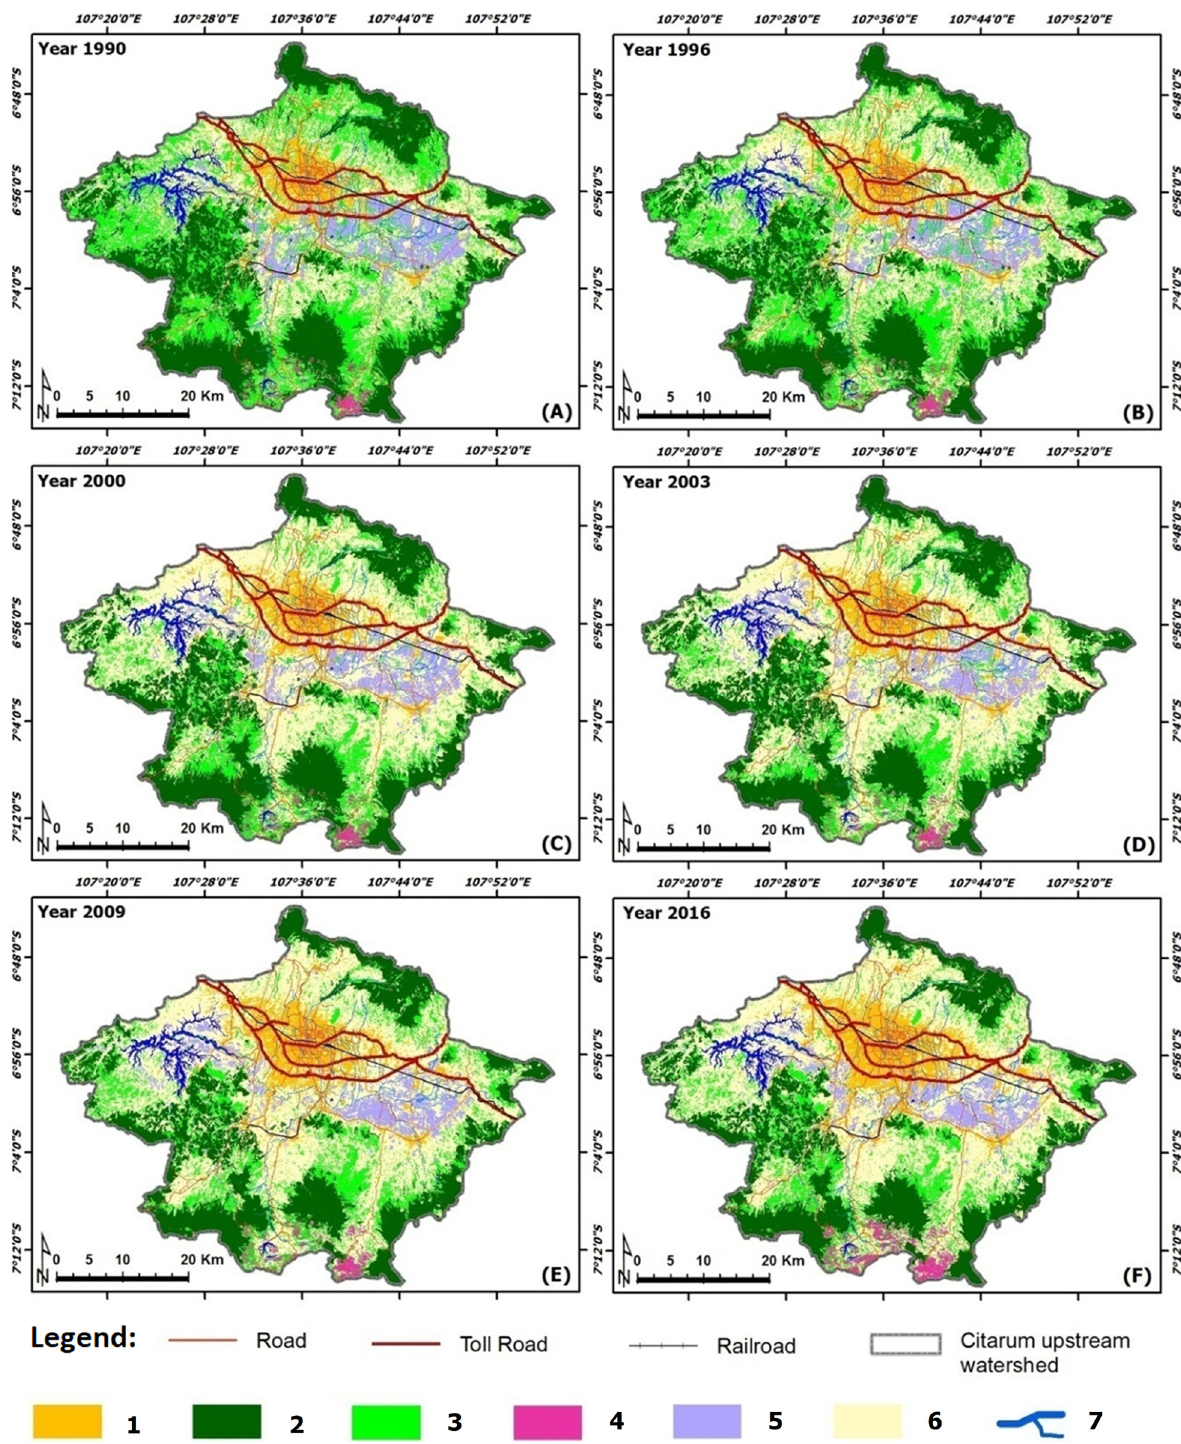
Fig. 3. LULC maps were used from various years during the period 1990–2016 (sourced and modified from Yulianto et al. (2018,